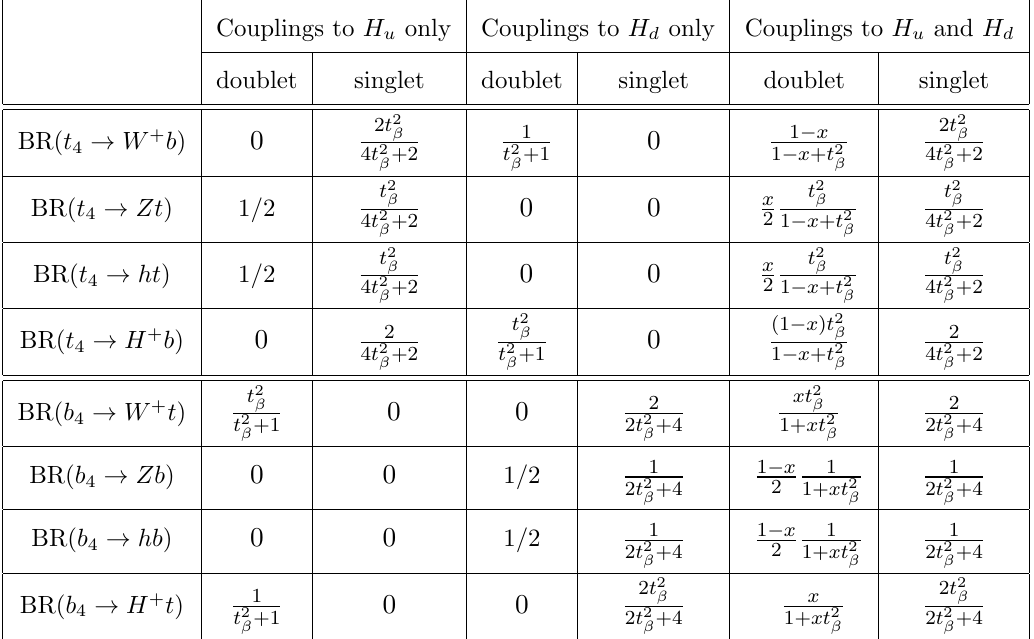
Table 5 . Branching ratios of the vectorlike quarks t 4 and b 4 into W , Z , h and H (cid:6) as a function of t (cid:12) = tan (cid:12) and x = (cid:20) 2 = ( (cid:20) 2 + (cid:21) 2 ). These expressions are an excellent approximation for heavy Q Q Q vectorlike masses and in the limit in which the couplings in table 2 dominate.